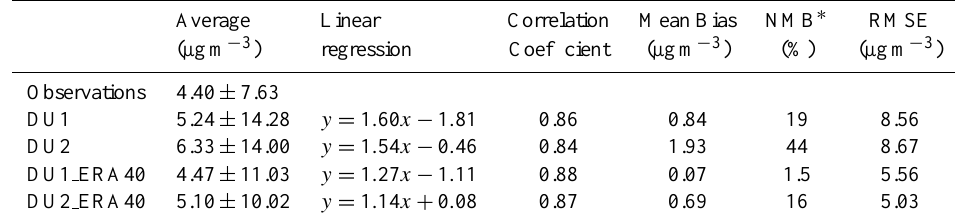
Fig. 6. Annual mean dust concentrations from the simulation of the year 2000 compared to measured multi-annual means at 24 stations. The colours correspond to the location of each station, as shown in Figure 3a. E-Pacific = red, W-Pacific = orange, S-Africa = blue, At- lantic = green, Australia = yellow, Asia = pink, S-Ocean = grey (the orange square with the x symbol is for the Midway Island station). The dotted lines denote the 1:10 to 10:1 range. Table 7. Statistics of the annual average dust concentrations. January has been